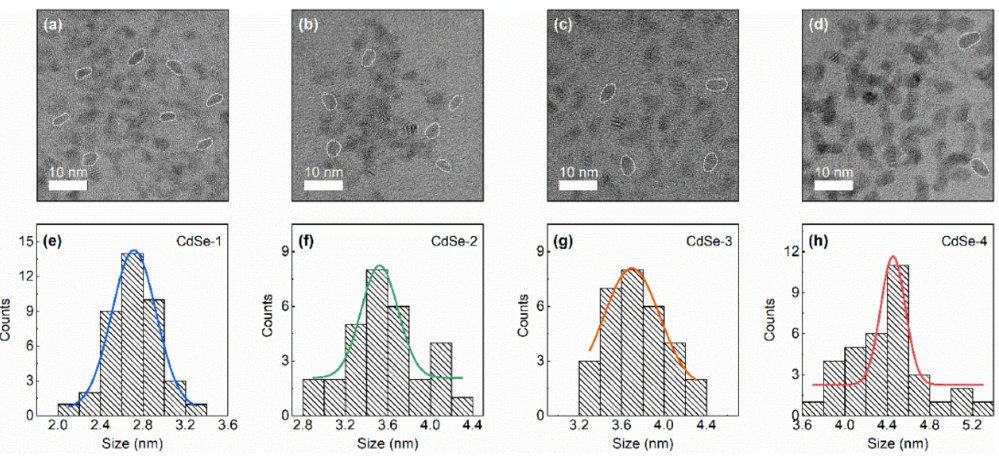
Figure 1. ( a – d ) TEM images with shape anisotropy as marked by dotted lines. ( e – h ) histograms of size distribution of CdSe QDs with Gaussian-fitting curves (solid line). The average sizes of QDs are ( e ) 2.7, ( f ) 3.5, ( g ) 3.7, and ( h ) 4.5